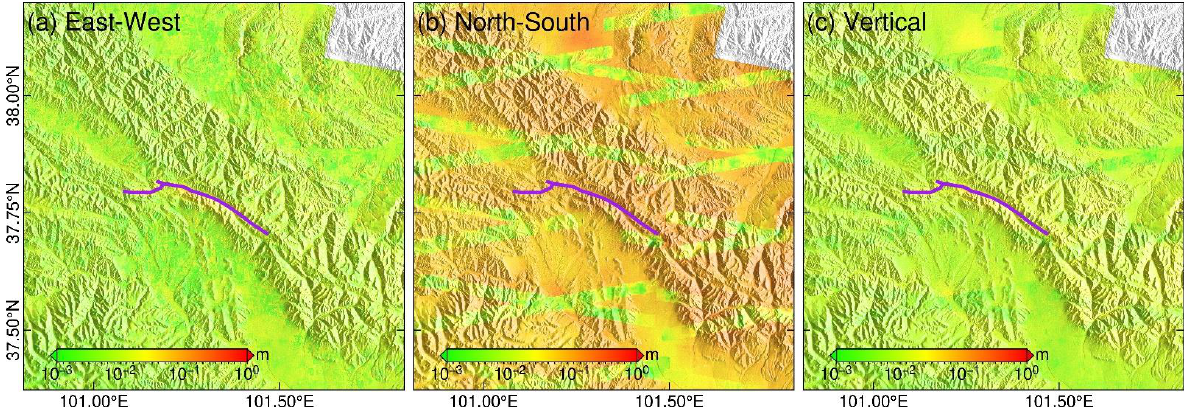
Figure 4. The variance of the 3D co-seismic displacements estimated using the SM-VCE method. ( a – c ) are the variance maps for the east-west, north-south, and vertical displacement components,